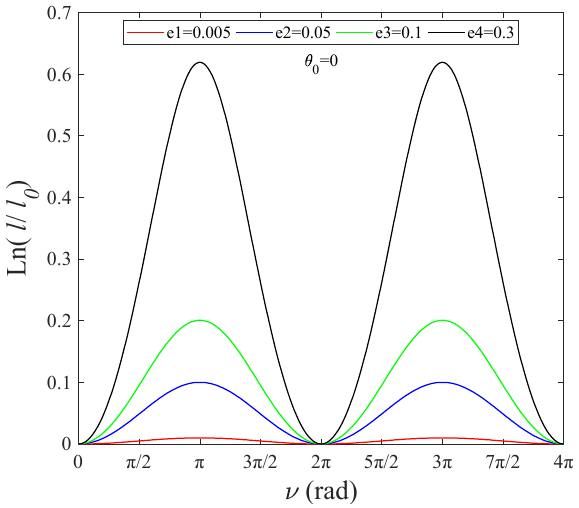
ν , const θ= . Figure 6. Log ratio of tether length versus ν , θ = const